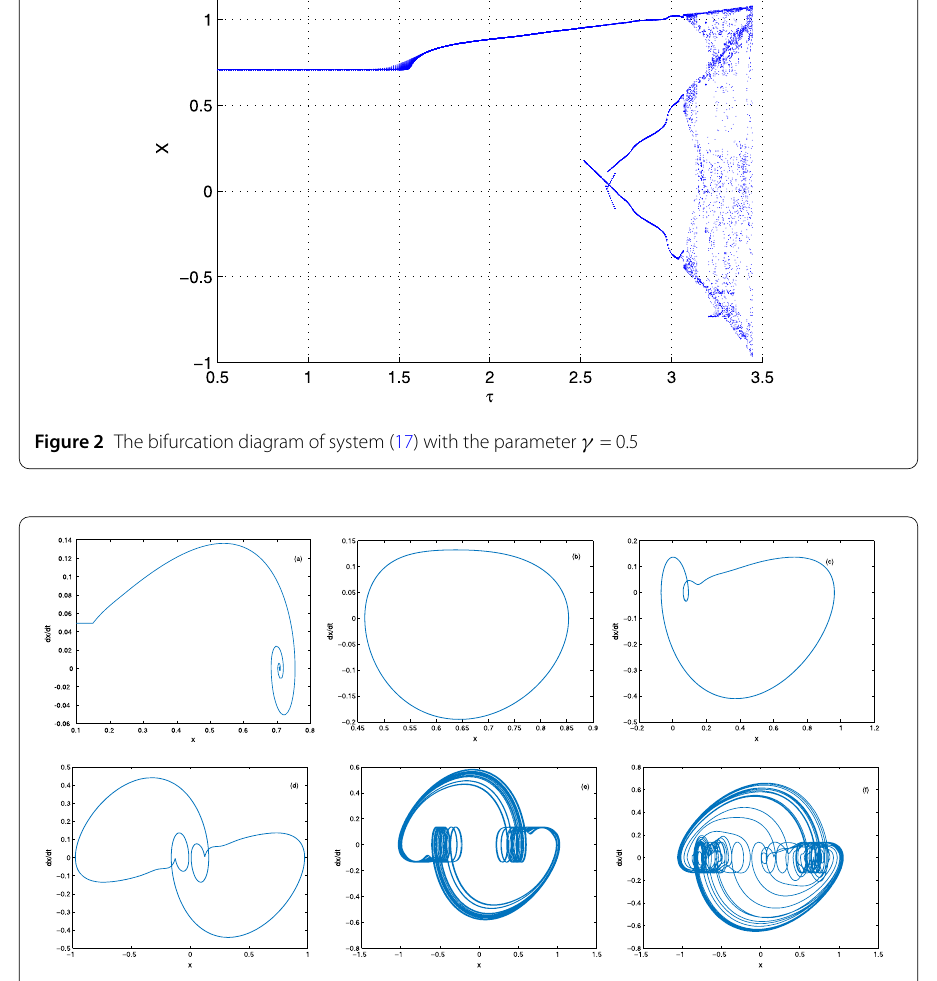
system becomes divergent at τ = 1.72. A phase plane representation in the representative x – dx / dt plane for different τ is shown in Fig. 5, which shows the following characteristics: stability ( τ = 0.5), period-1 ( τ = 0.9), period-2 ( τ = 1.3), period-4 ( τ = 1.35), and chaos ( τ = 1.55 and τ =